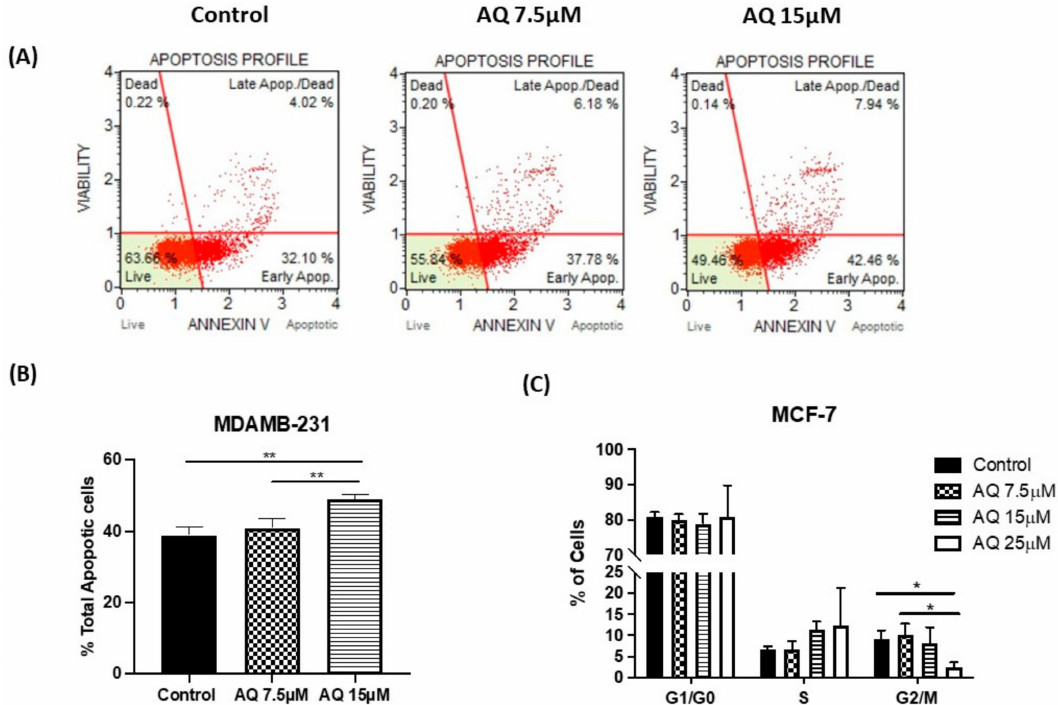
Figure 8. ( A ) Apoptotic impacts of different concentrations of AQ on MDAMB-231 cell line. ( B ) Total % apoptotic profile: Graph representing total % of apoptosis when treated with AQ (7.5 and 15 µ M) relative to control. ( C ) Plot represents population of cells in various phases of cell cycle. A significant difference can be seen in the population of cells in the G2/M phase as AQ concentration is increased from 7.5 to 25 µ M, indicating less population of cells are pushed towards mitosis. Data represents mean ± SD ( n = 3), * p < 0.05, ** p < 0.01. compared between treatment and control group and among treatment groups as